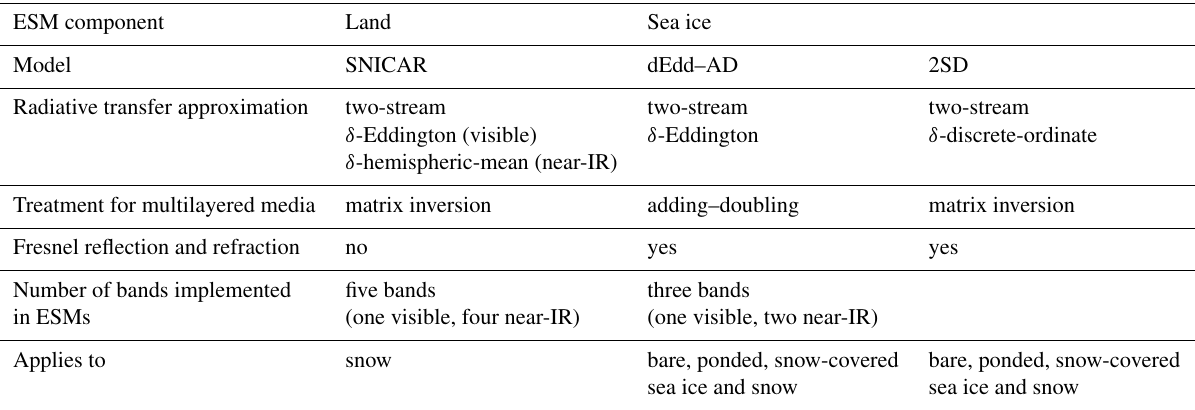
Table 2. Two-stream radiative transfer algorithms evaluated in this work, including algorithms that are currently implemented in Earth system models CESM and